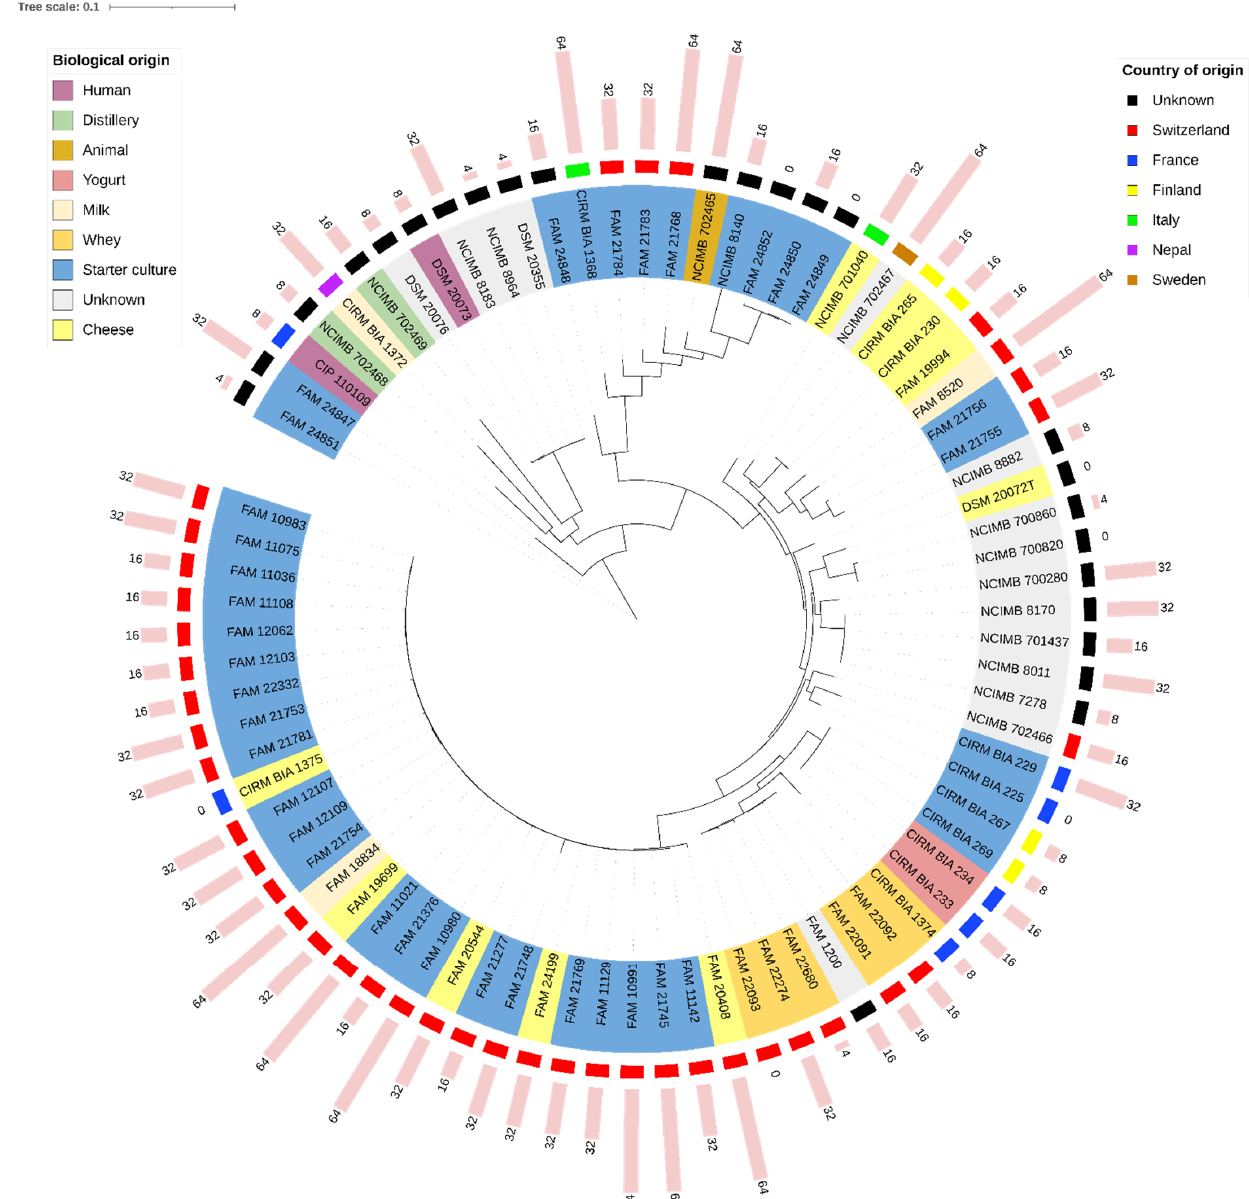
Figure 2. SNP-based phylogenetic tree of the Lactobacillus delbrueckii subsp. lactis strains assessed in this study. Country and biological origin, as well as the defined minimal inhibitory concentration of kanamycin (MICs, pink bars, along with their numerical values expressed in mg/L) are displayed. For strains that did not grow in the test medium or that have not been tested, MIC of kanamycin is indicated with ‘0 (cid:48) . The scale shows the rate of single nucleotide